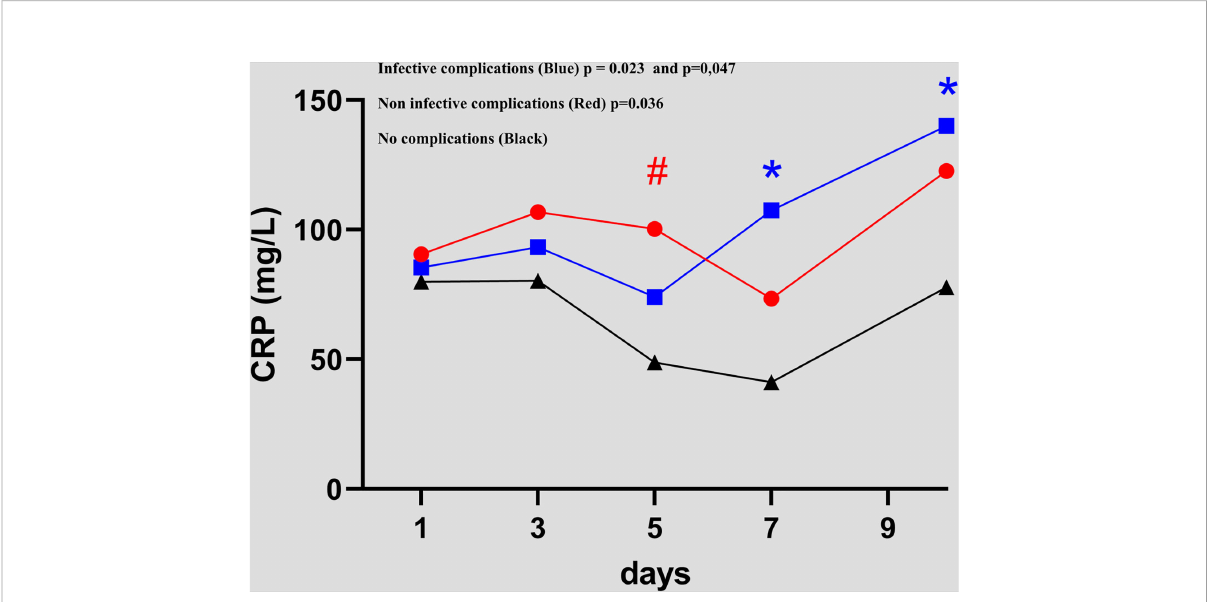
FIGURE 1 Evolution of C-reactive protein value between day 1 and day 10 in the 3 groups (NCs versus ICs and NCs versus NICs groups). . #, * = statistically signi fi